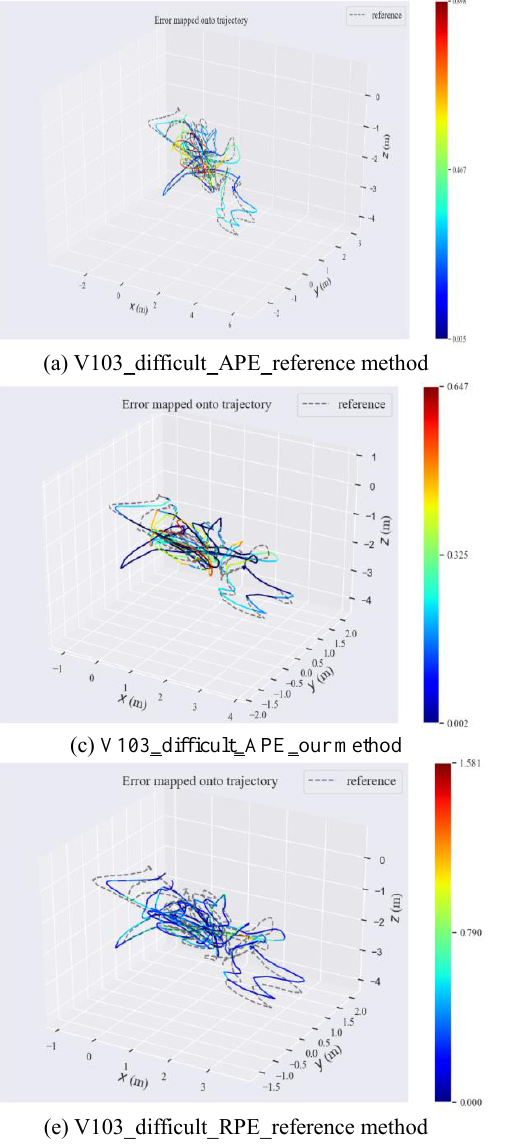
Fig.9 V103_ difficult APE and RPE comparison